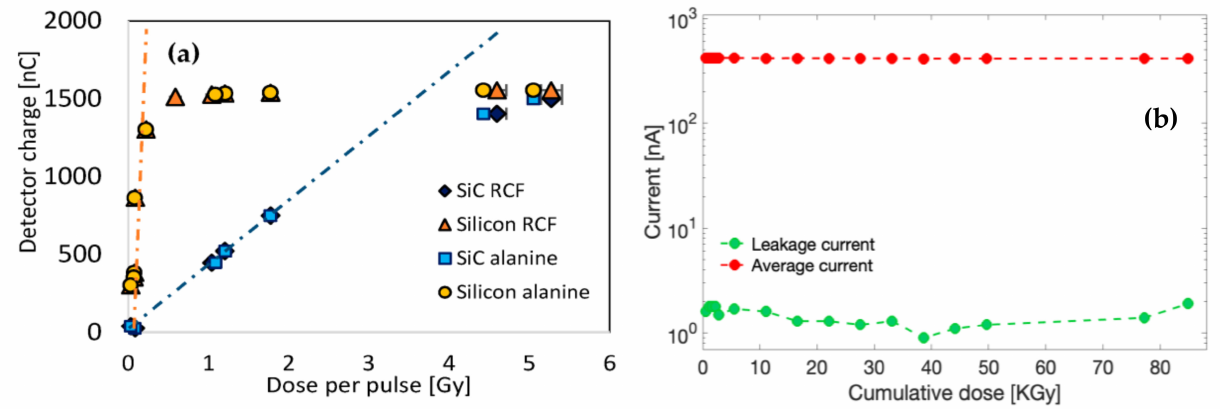
Figure 5. ( a ) SiC response measured with the Keithley 6517A electrometer as a function of the dose per pulse measured with the RCF and the alanine detectors placed in the same location of the detectors. Cross comparison with a commercially available Silicon diode from PTW is also shown. ( b ) Leakage current of the SiC detectors after each irradiation and average current detected as a function of the cumulative dose delivered at the SiC